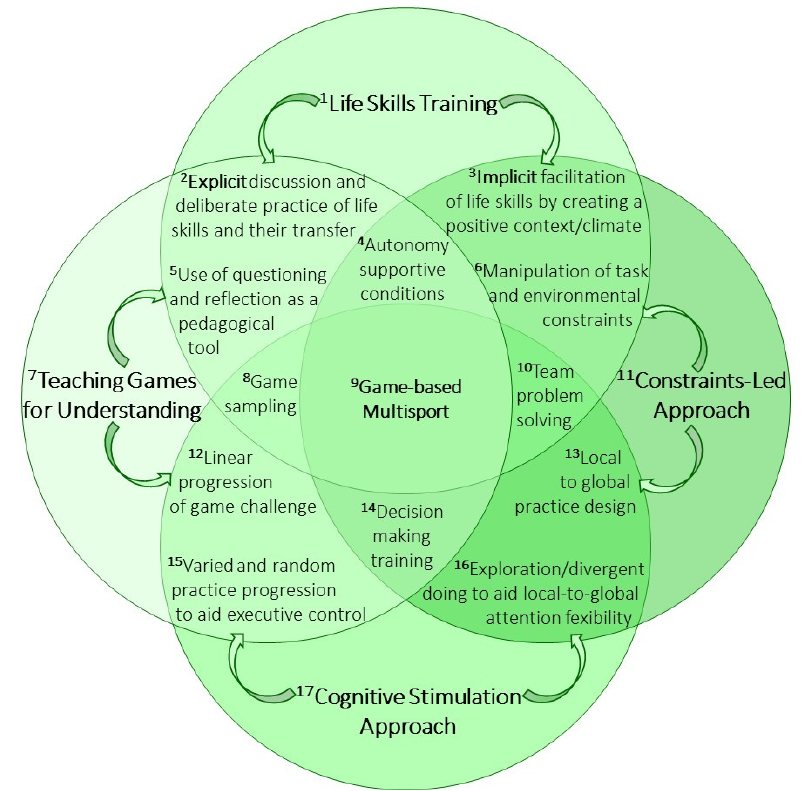
Figure 2. Integrative, theory-based enriched PE intervention with a multisport design centered on team games. 1 : [16,17]; 2 , 3 : [15]; 4 : [51,52]; 5 , 6 : [37]; 7 : [33,34]; 8 : [33]; 9 : [18,53]; 10 : [54]; 11 : [47,48]; 12,13 : [37]; 14 : [55,56]; 15 : [57]; 16 : [58]; 17 : [41,49].